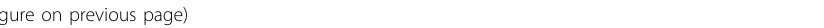
Fig. 4 High-content screen for CRMP2-phosphorylation modulators. a Z ′ factor = 0.6 was calculated with 10 μ M CHIR-99021 used as positive control in the high-content screen. b High-content screen of 240 compounds for p-CRMP2 T514 modulators ( n = 3 replicates). GSK3 inhibitors are most effective modulators down-regulating p-CRMP2 T514 levels to below 80%, indicated by blue bracket. Smaller effect is detected for a group of potential hits (green bracket). c Graph of the data for GSK3 inhibitors from the screen. d Re-test of a group of novel modulators that are lysine deacetylase inhibitors. Crebinostat, a novel HDAC inhibitor demonstrated to enhance fear conditioning 86 , was included though it was not present in the library. All compounds are retested at 10 μ M except crebinostat at 1 μ m. Lithium ’ s effect at 1 mM was set to 100%. e Re-test of other novel modulators (10 μ M), some of which are involved in regulation of neurotransmission. In vitro GSK3 β enzymatic assay showing no direct GSK3 β inhibitory activity detected for the group of compounds. Unpaired t -test: * 0.01 ≤ p < 0.05, ** 0.001 ≤ p < 0.01, *** 0.0001 ≤ p < 0.001, **** p < 0.0001. f Chemical structures of novel p-CRMP2 T514 modulators that are non-lysine deacetylase inhibitors. g Chemical – protein interaction network presented by STITCH reveals connectivity of novel p-CRMP2 T514 modulators to lysine deacetylation and